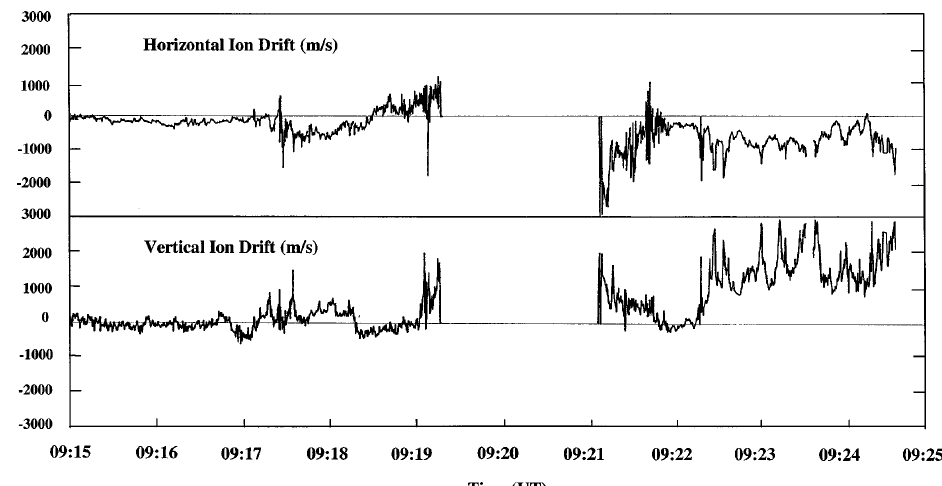
Fig. 9. Horizontal ( top panel ) and vertical ( lower panel ) ion drift velocities measured during the DMSP satellite pass at 0920